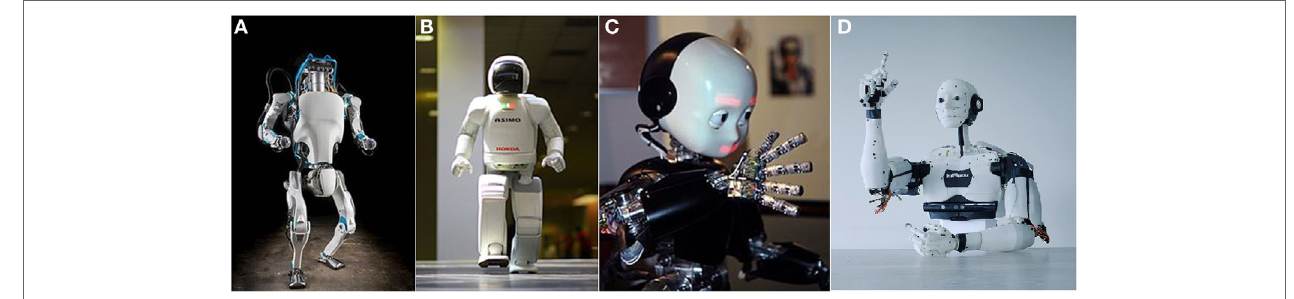
FigUre 3 | Humanoid robots (first row from left to right): (a) Atlas robot, (B) ASIMO robot, (c) i-Cub robot, and (D) InMoov